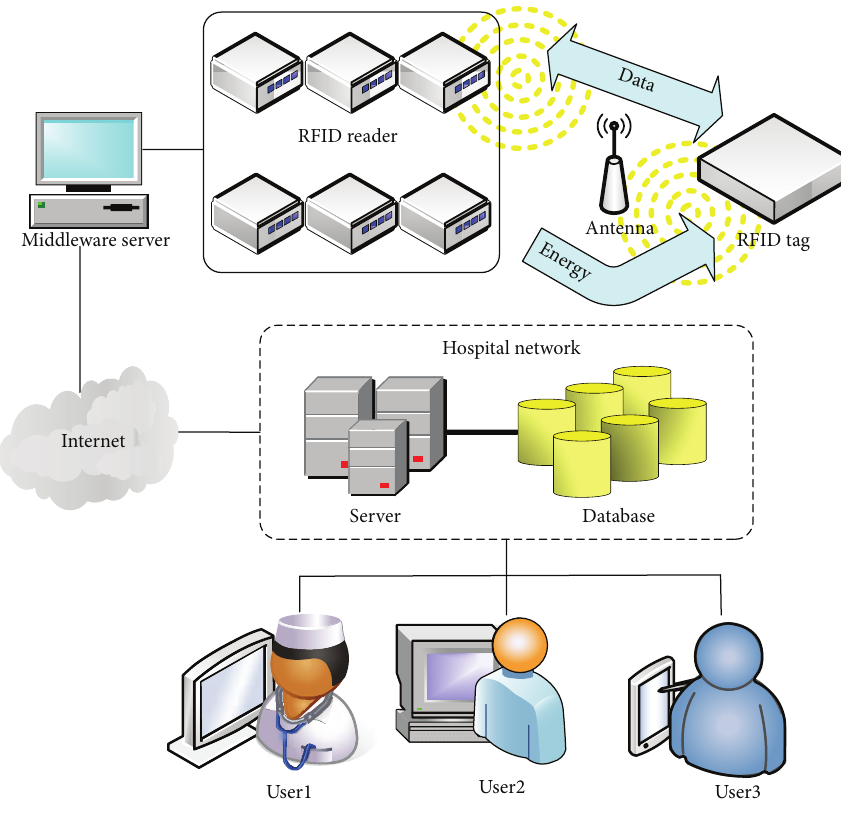
Figure 1: Functional component of the RFID System using in medical environment.